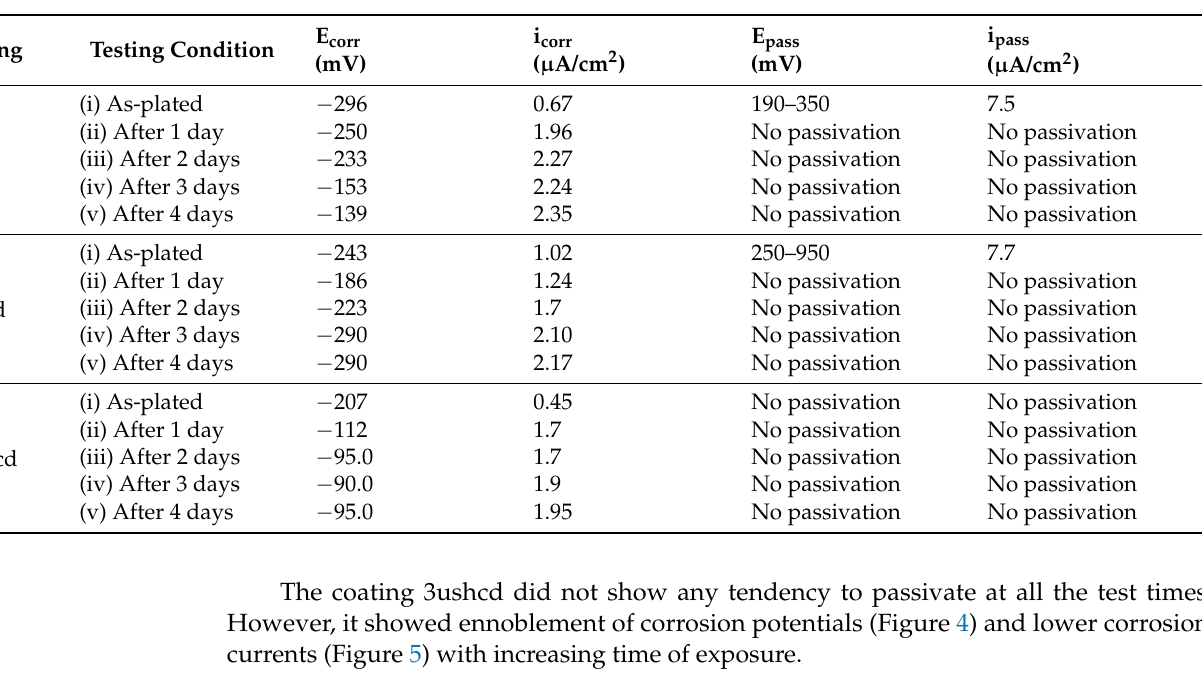
Table 2. Results of electrochemical polarization.